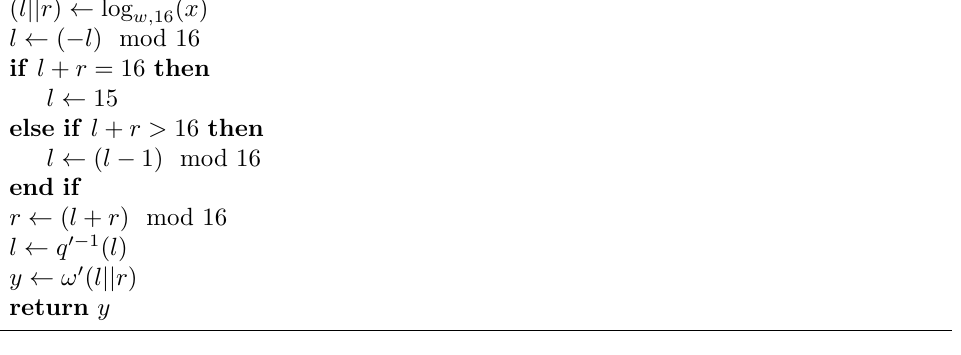
Algorithm 3 Computing the S-Box 𝑦 = 𝜋 ( 𝑥 ) using a second decomposition.